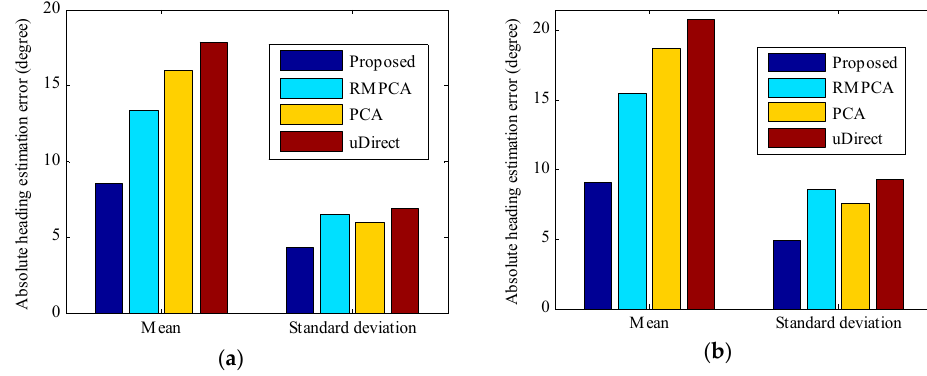
Figure 10. Mean and standard deviation of absolute heading estimation error with carrying position transitions in the second scenario: ( a ) Environment 1; ( b ) Environment 2.